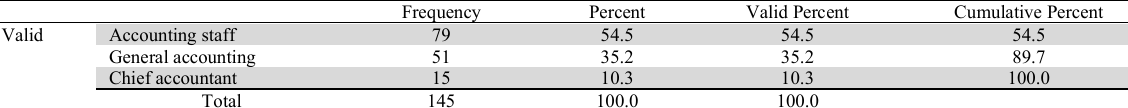
Respondents by Jobs